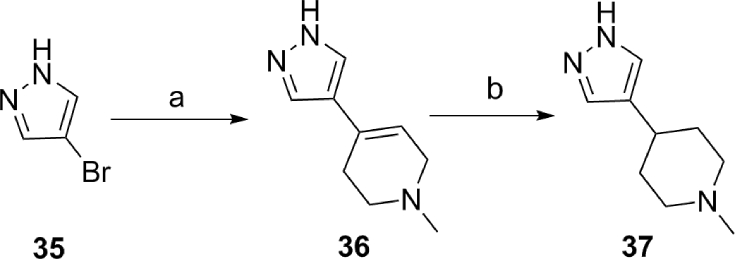
aReagents and conditions: (a) (i) 2.5 M nBuLi in hexane, THF, −78 °C to room temp (1.5 h) then cool to −78 °C, (ii) 1-methylpiperidin-4-one, warm up to room temp, 1.5 h, then AcOH/TFA, 90 °C, 4 h; (b) 10% Pd/C, EtOH, 1 M HCl, H2, 16 h.